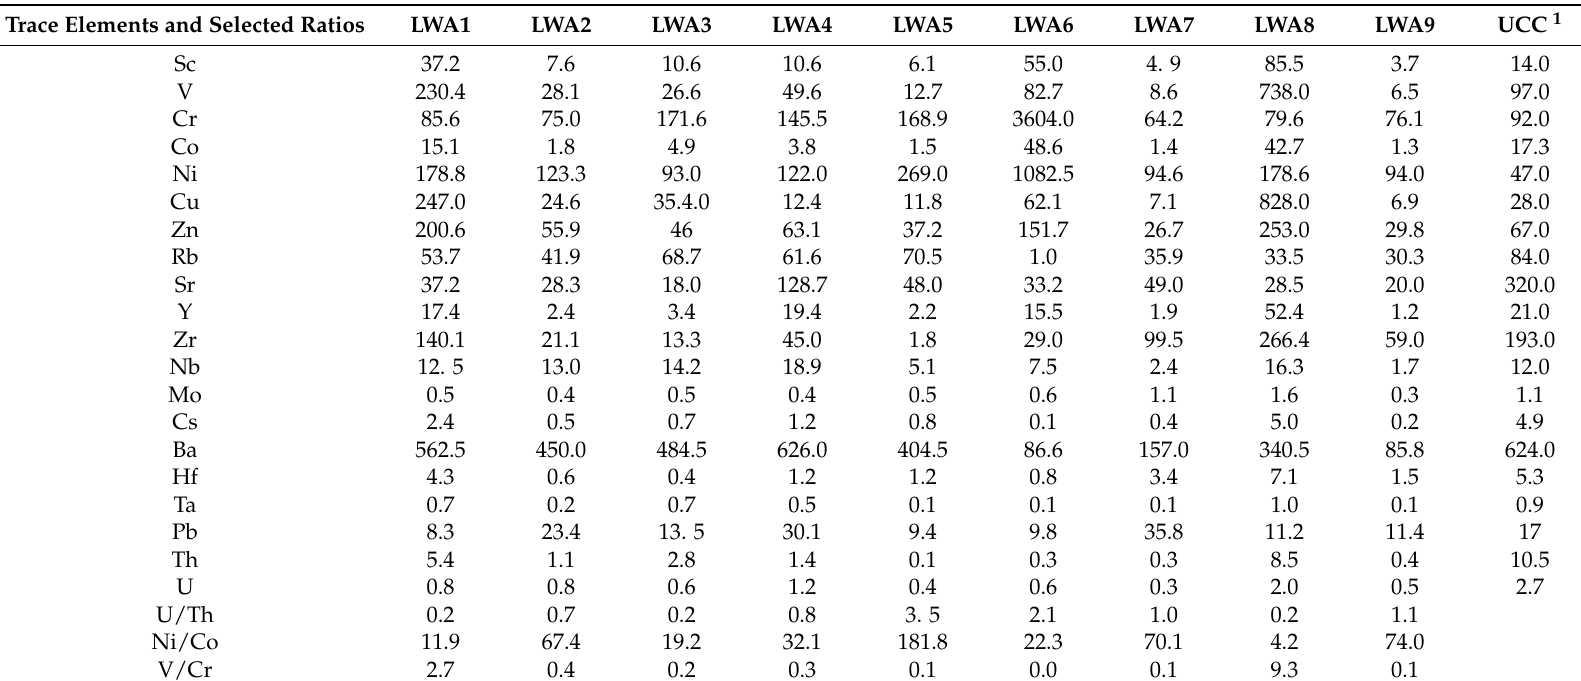
Table 3. Trace element composition in ppm of the clay fraction of the Lwamondo kaolin (arranged in increasing atomic number from Sc to U). Trace Elements and Selected